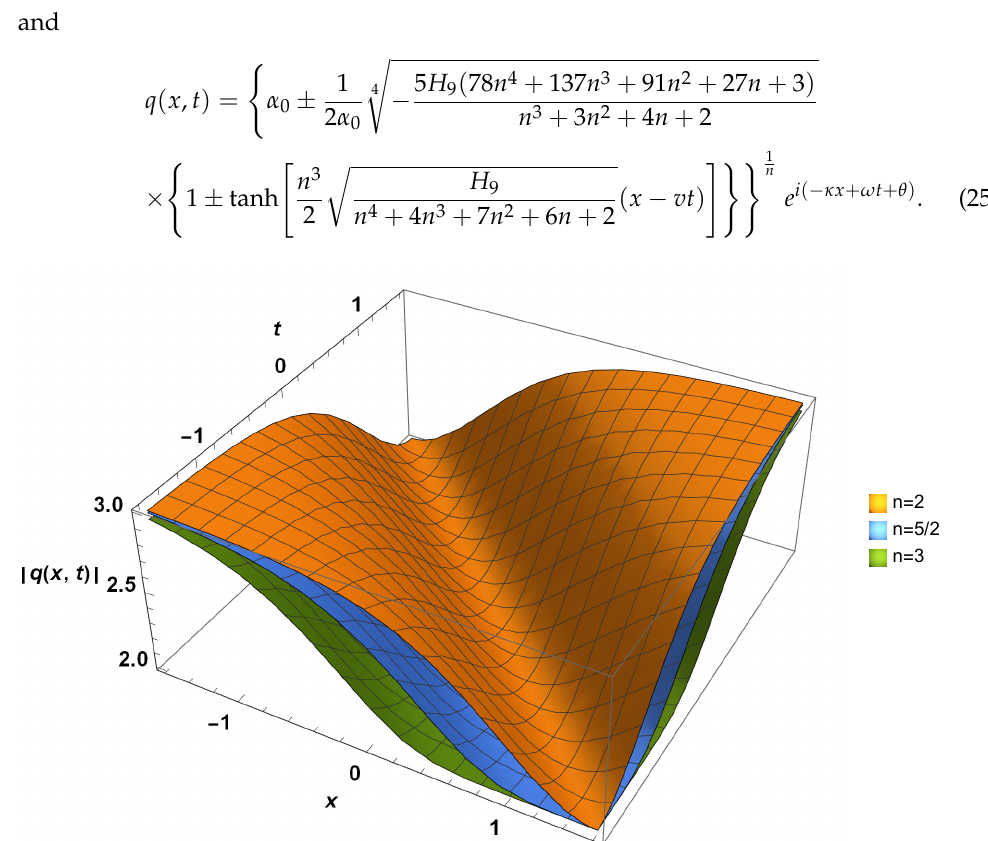
Figure 2. The amplitudes of a dark HD optical soliton (25), with α 0 = 1, b 6 = 1, a 6 = 1, k = 1, κ = 1, a 4 = 1, a 3 = 1, and a 2 =